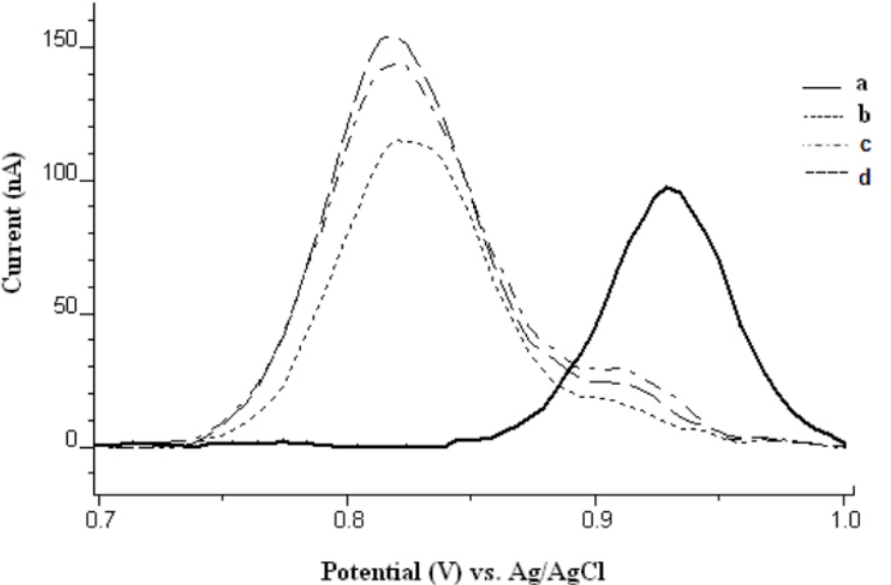
Figure 3. DPV signal of guanine at different preatreated electrodes: a) CPE , b) MWNTPE performed in 0.20 M acetate buffer solution pH 5.00 for 20 s. The accumulation step was performed at 0.50 V for 5 min in a 0.20 M acetate buffer solution pH 5.00 containing 20 mg L -1 dsDNA. The stripping was performed in a 0.20 M acetate buffer solution pH